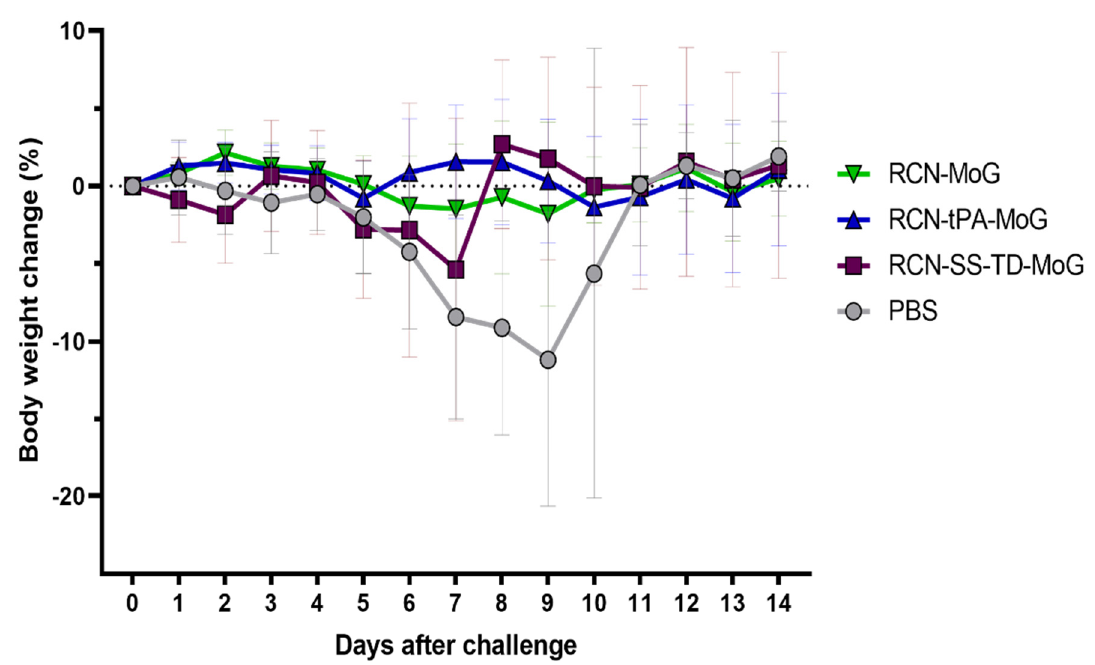
Figure 5. Changes in mean mouse body weights (as percentage of weight change from day 0) over time (in days) following challenge with RABV. Weight change is presented as percentage of initial body weight lost or gained after challenge, with standard deviations. The percent change in mean weights of mice in the control group (PBS) trends downward from day 6 to day 9.